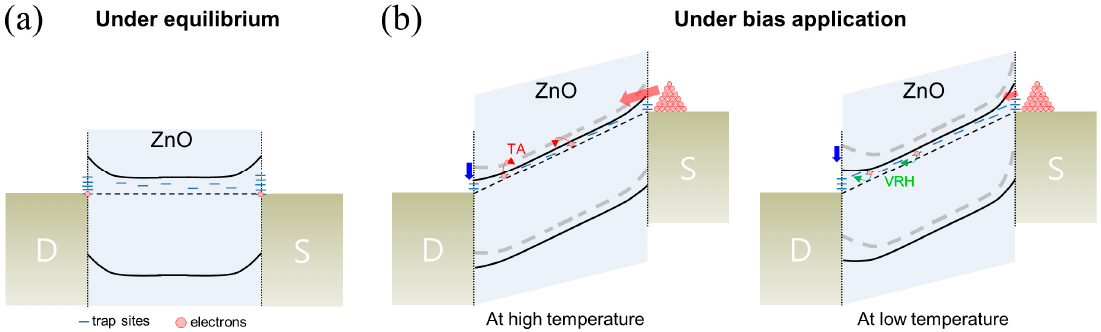
Figure 5. Energy band diagrams depicting the charge transport mechanism for the ZnO nanowire FET ( a ) under equilibrium and ( b ) under bias application at low and high temperatures. The blue arrow indicates Schottky barrier modulation according to the applied gate and drain voltages.